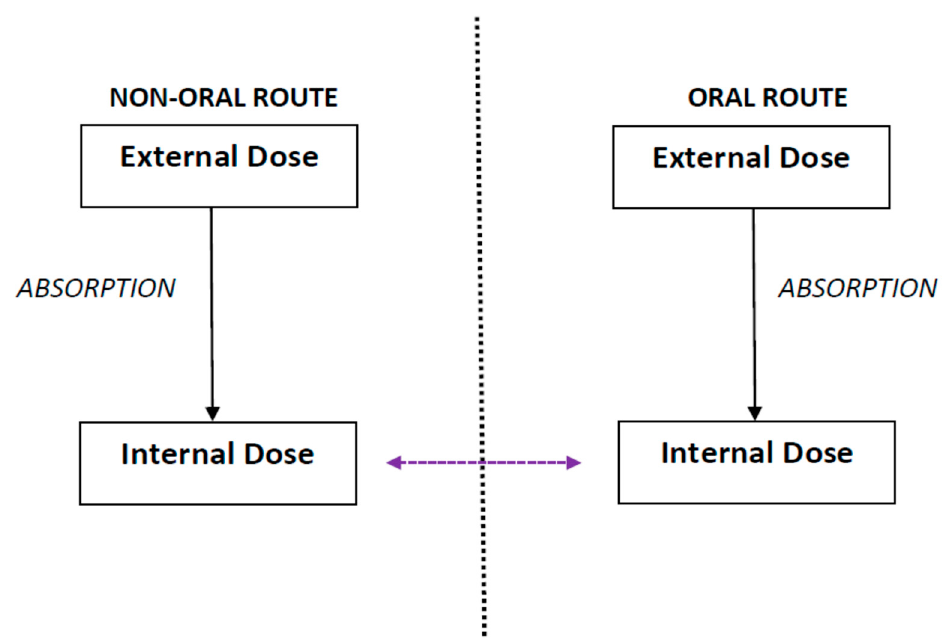
Figure 1. Route-to-route extrapolation refers to extrapolation of the internal dose from one exposure route, such as non-oral (inhalation, dermal, etc.) to another, such as oral, or vice-versa, such that prediction of effects is based on the internal dose instead of the external exposure.